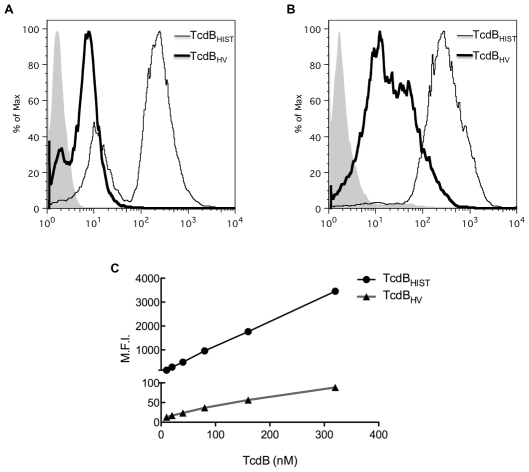
Flow-based analysis of cell binding.TcdBHIST and TcdBHV were tested for their ability to bind CHO (A) and HL-1 cells (B). 40 nM of fluorescently labeled TcdB was incubated with cells on ice, and binding was determined by flow cytometry. TcdBHIST and TcdBHV are indicated, and shaded peaks represent cells incubated with unlabeled TcdB. (C) Mean fluorescence intensity (MFI) vs TcdB concentration on HL-1 cells. Please note the difference in axis for TcdBHIST and TcdBHV.